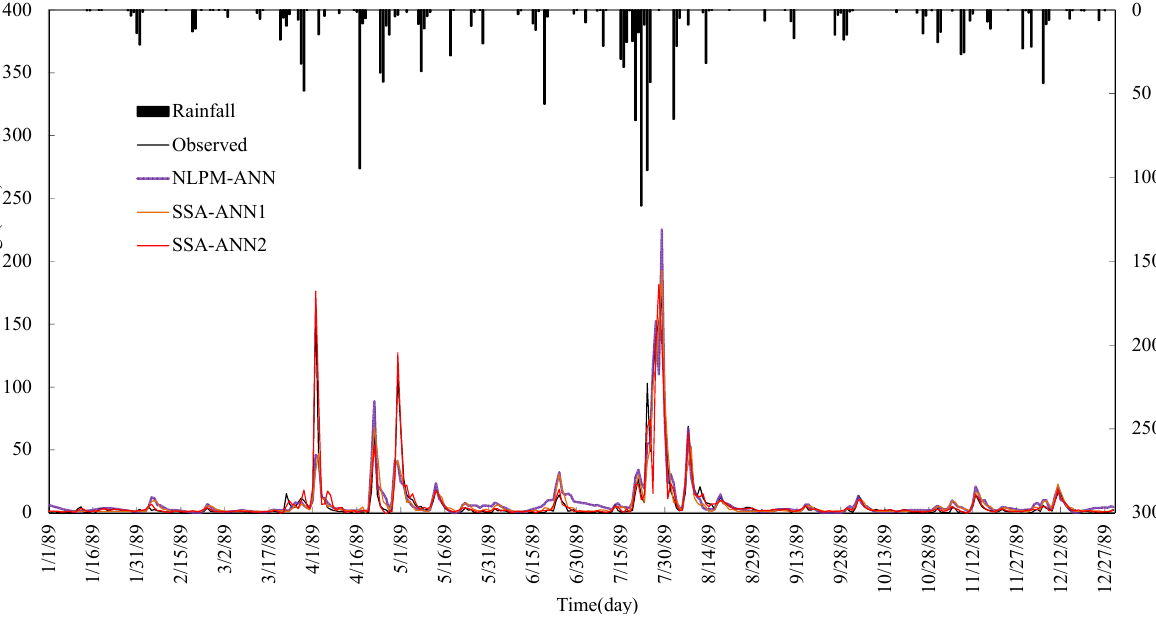
Figure 9. Observed and simulated runoff hydrographs by three models for